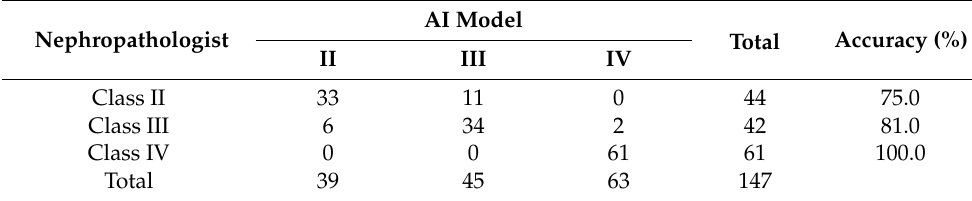
Table 1. AI model predictions versus nephropathologist